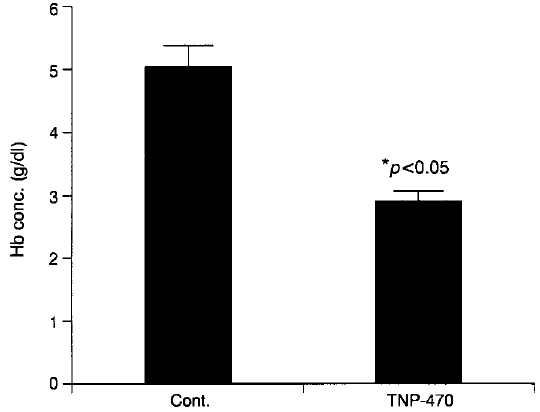
Fig. 6 . Angiogenic ability of the conditioned medium from TNP-470 treated HT1080 cells. Matrigel plug neovasculariza- tion was quantitated by measuring the hemoglobin content of the pellets with the conditioned medium from HT1080 cells treated with or without TNP-470 using Drabkin’s methods. Hemo- globin concentration of the pellets with the conditioned medium from HT1080 cells treated with TNP-470 was significantly lower. Columns, mean of 5 mice/group; bars,